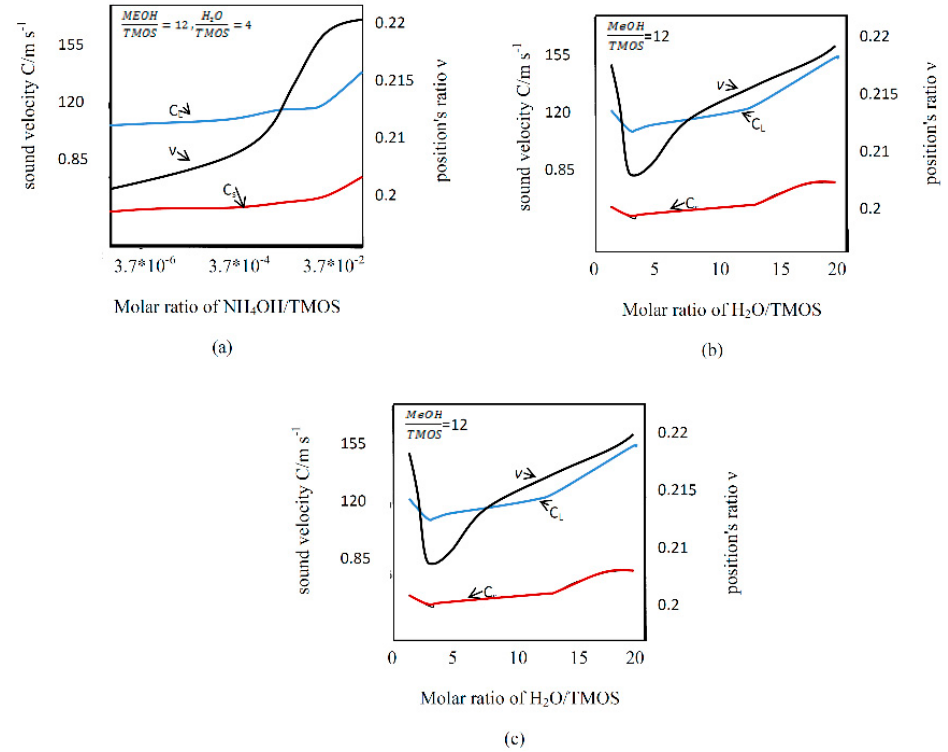
Figure 7. Sound velocity in silica aerogel versus: ( a ) NH 4 OH/TMOS molar ratio, ( b ) MeOH/TMOS molar ratio, and ( c ) H 2 O/TMOS molar ratio [72].